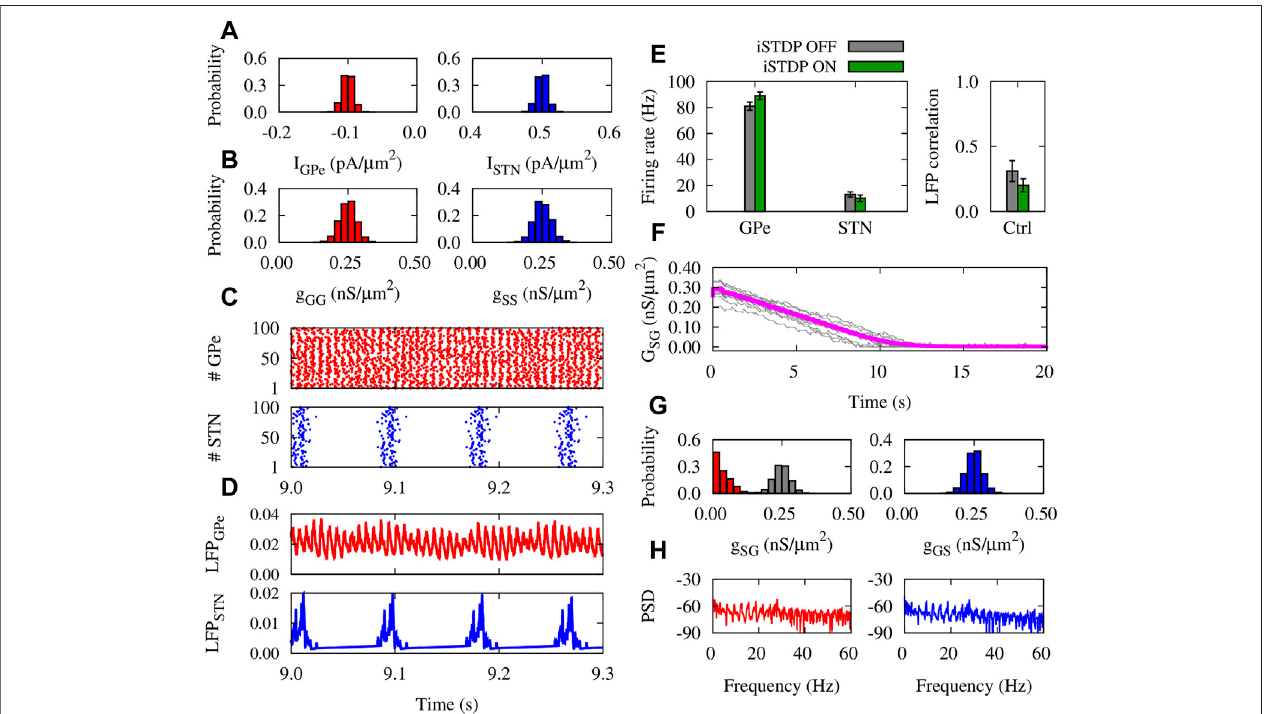
FIGURE 4 | Properties of the GPe-STN network mediated by iSTDP in control condition. (A) Normal distribution of currents applied to GPe (left) and STN (right) around I GPe = − 0.1 pA/ μ m 2 and I STN = 0.5 pA/ μ m 2 . (B) Normal distribution of GPe-GPe (left) and STN-STN (right) synaptic strengths around 0.25 nS/ μ m 2 . (C) Raster plots of GPe (top) and STN (bottom). (D) LFP of GPe (top) and STN (bottom) de fi ned in Eq. 13 . (E) Mean fi ring rate of GPe and STN neurons (left) and the correlation between the GPe and STN LFPs (right). (F) Time course of the mean GPe-STN coupling (magenta) and ten randomly chosen individual synaptic strengths (grey). (G) Normal distribution of the initial GPe-STN (left; grey) and STN-GPe (right) synaptic strengths. Final distribution of the GPe-STN synaptic strengths is depicted in red (left). (H) PSD of the GPe (left) and STN (right) LFPs.